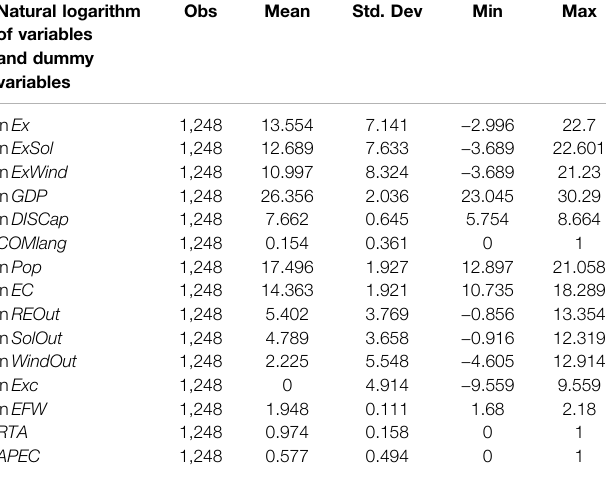
TABLE 2 | Descriptive statistics.